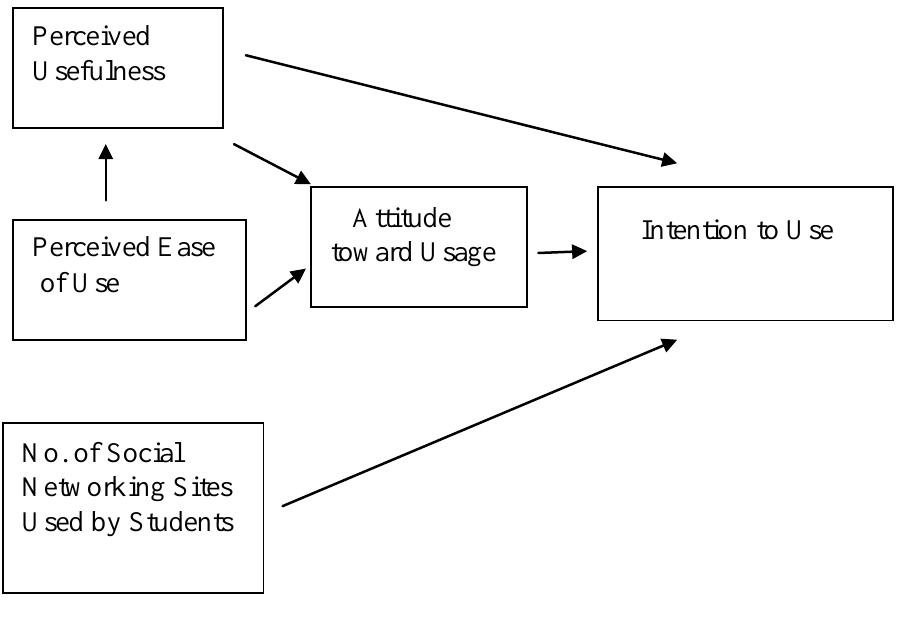
Figure 1. Technology acceptance model adapted from Davis et al